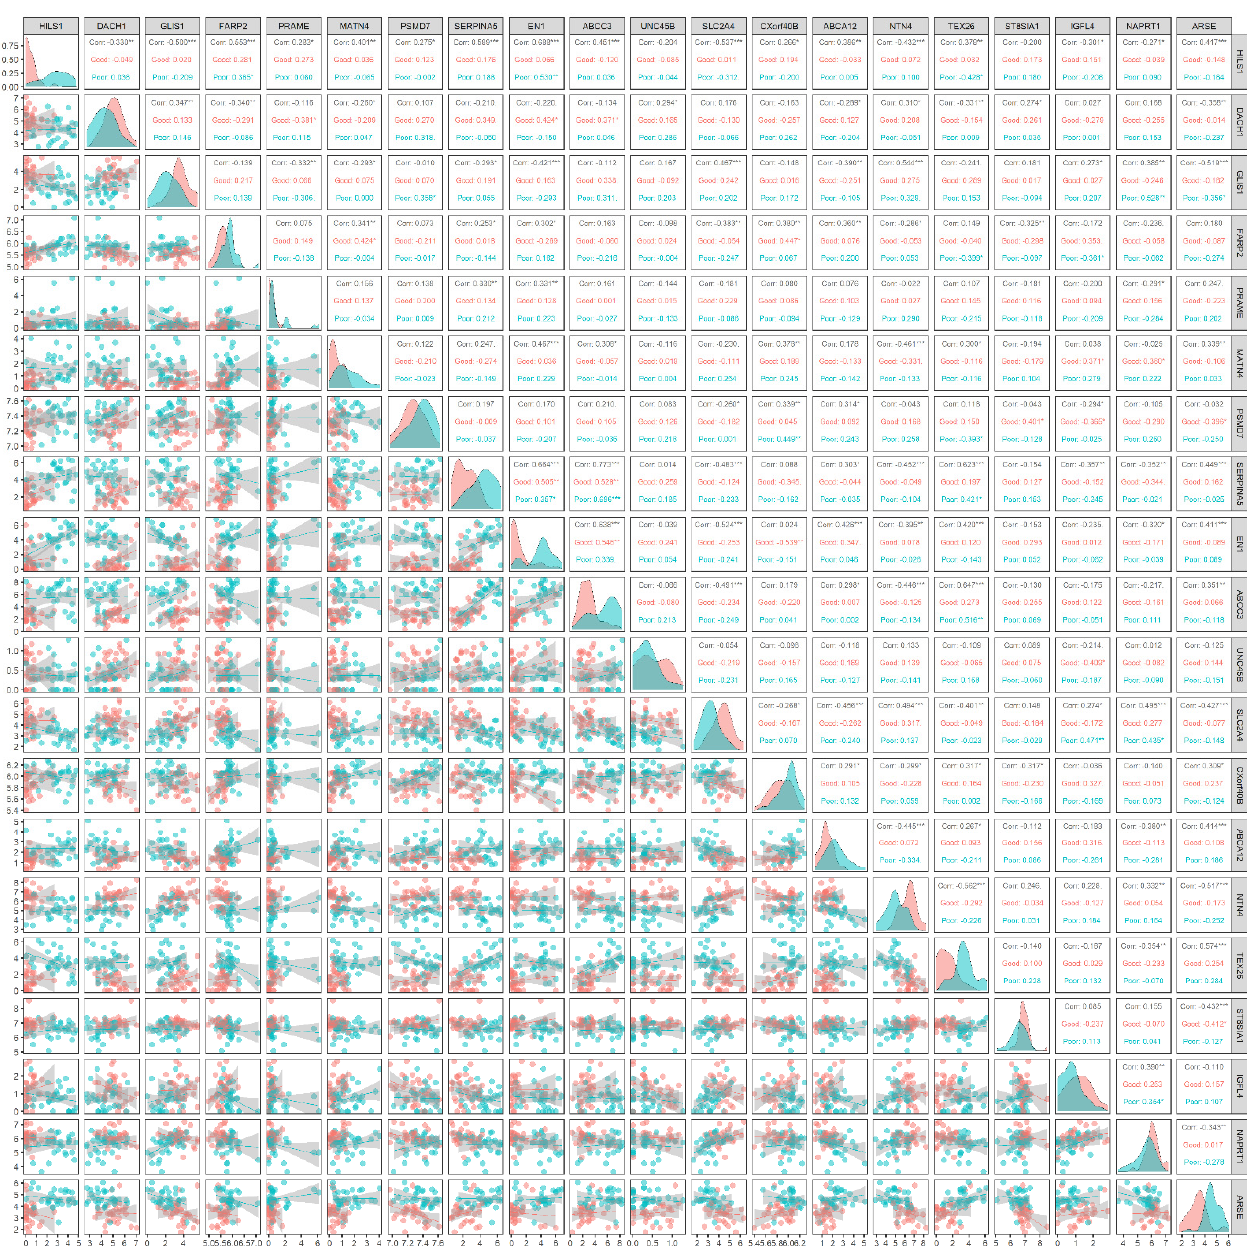
Figure 3. Joint distributions of gene expression of the estimated prognostic genes. The good prognosis group and the poor prognosis group are in the first quartile and the fourth quartile of survival days, respectively. Diagonal elements represent the marginal distribution of each gene. Lower-triangle elements exhibit the sample distribution for the groups. Upper-triangle elements display the correlation in each group. In the correlation, the symbols *, **, and *** indicate p < 0.05, < 0.01, and < 0.001, respectively. It is established that the expression of HILS1 is correlated with the expression of other prognostic genes; 17 genes are correlated with HILS1 ( p < 0.05), while 8 genes are highly correlated ( p < 0.001), implying that HILS1 is a biomarker likely to regulate the expression of other prognostic genes.